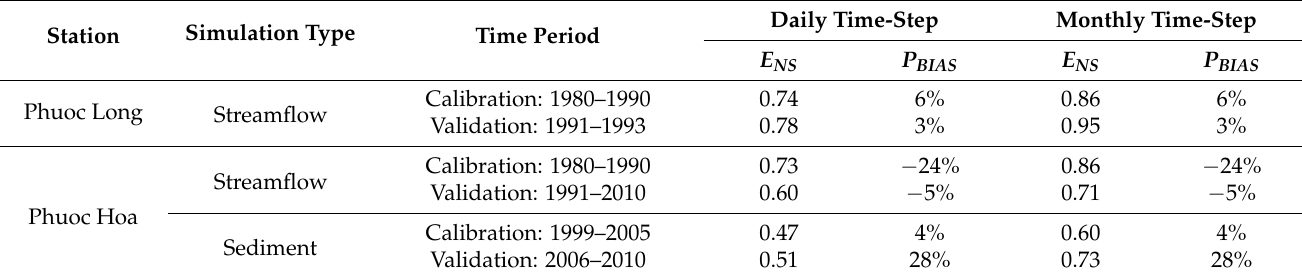
Table 4. SWAT performance statistics for the simulations of streamflow and sediment load at the daily and monthly time-steps.